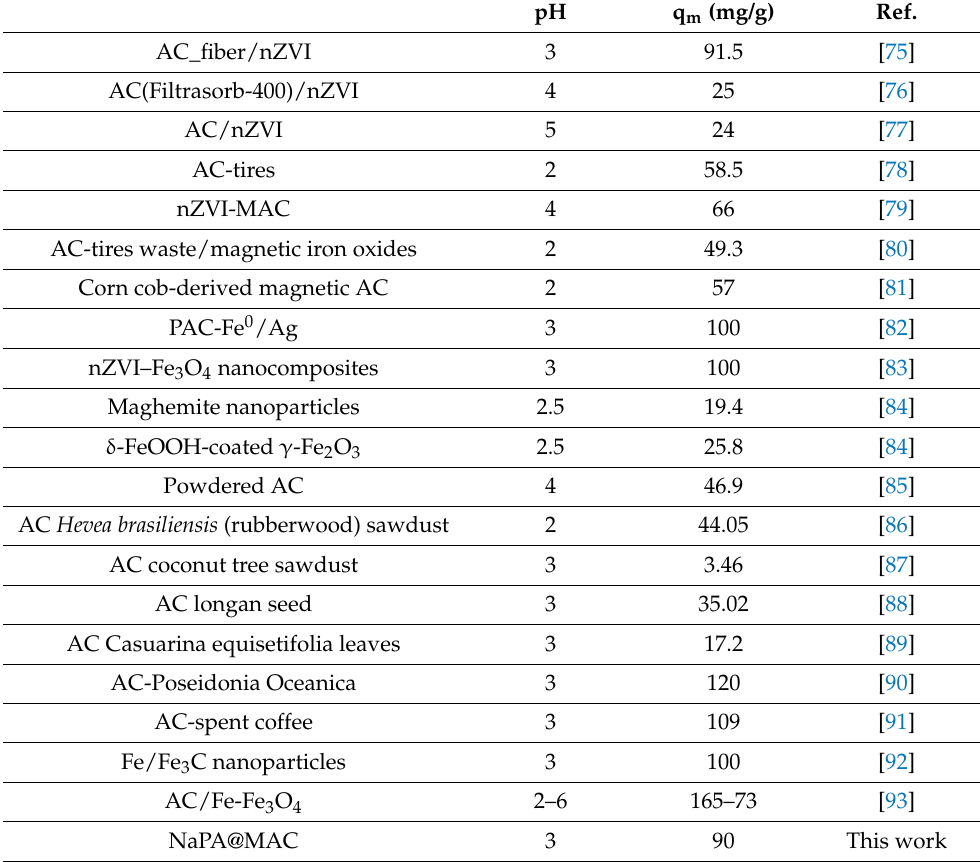
Table 5. Adsorption capacities (q m ) of Cr(VI) on NaPA@MAC and other adsorbents reported in the